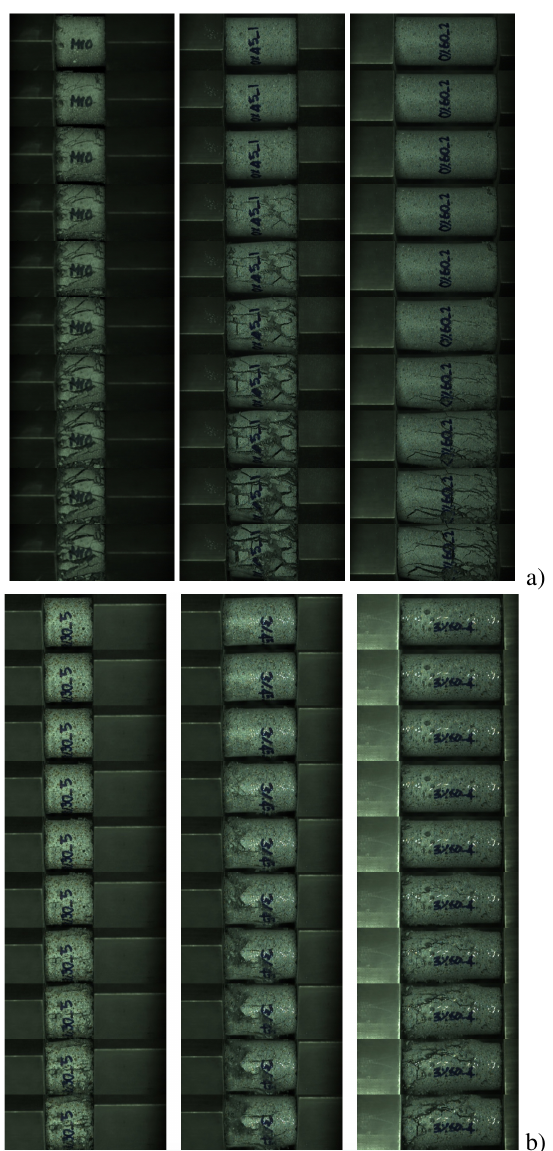
Figure 5. Comparison between matrix (a) and UHPFRC (b)